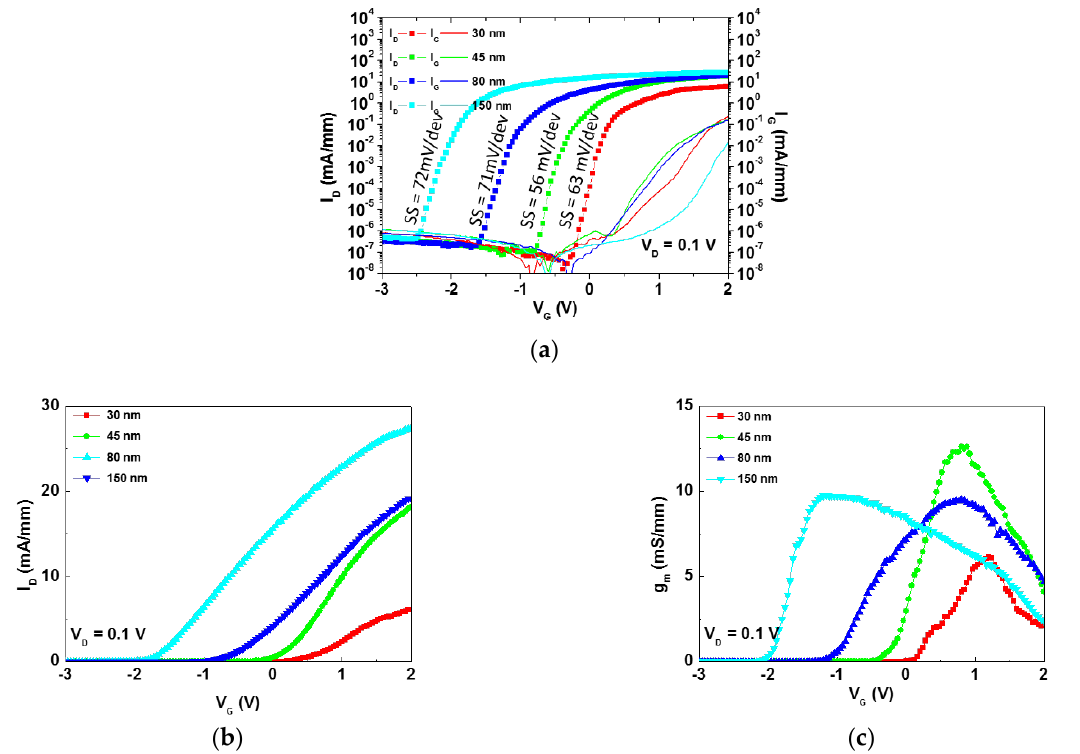
Figure 2. Sloped sidewall MIS-FinFETs with 20 nm-thick SiO 2 gate dielectric varying the W fin from 150 to 30 nm. ( a ) Logarithmic transfer curves; ( b ) Linear transfer curves; ( c ) Transconductance curves. Table 1. Key parameters for each device exhibited in Figure 2.